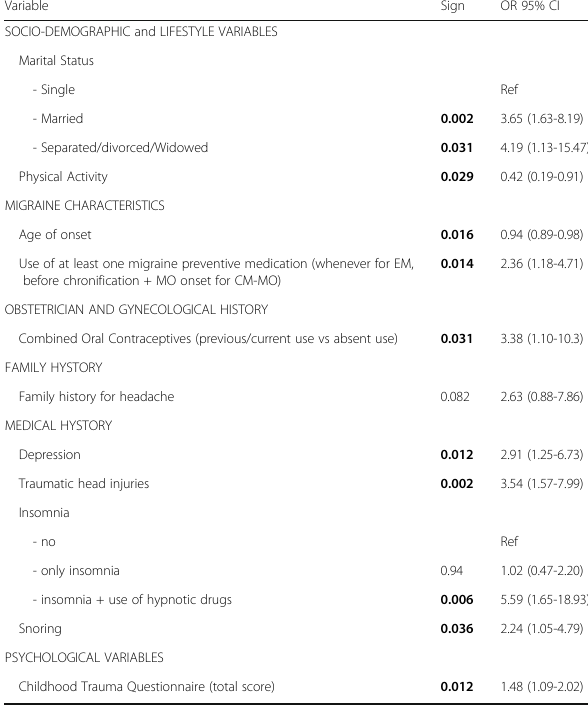
overuse (MO) is considered to be one of the main determinants, but other possible clinical and psychological factors can play a role. The aim of this study was to identify some of these factors.